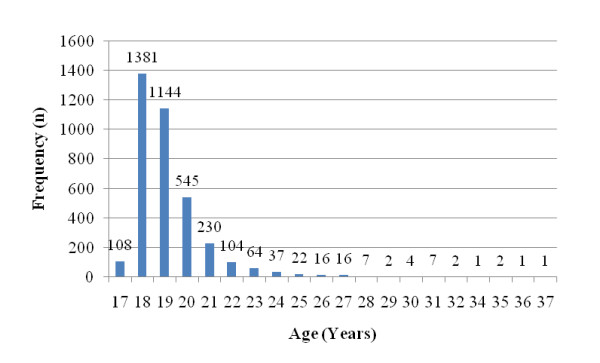
Participants according to age groups.